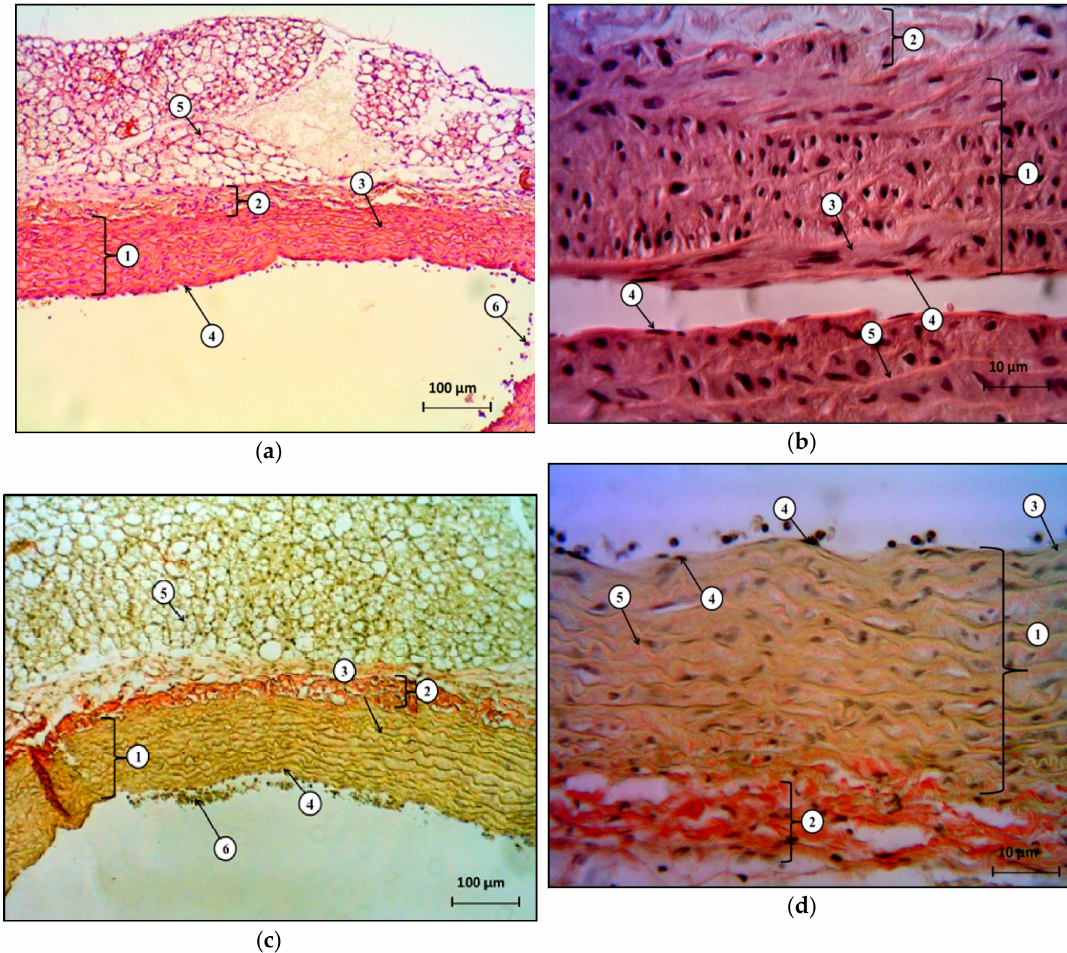
Figure 4. The histological structure of the abdominal aorta in the group with no treatment 43 days after bilateral ovariectomy: ( a ) stained with hematoxylin and eosin, x40; ( b ) stained with hematoxylin and eosin, x400; ( c ) stained by Van Gieson’s method, x40; ( d ) stained by Van Gieson’s method, x400. Designations: ( a ), ( c ): 1—middle shell; 2—outer shell; 3—graduated elastic membranes; 4—endotheliocytes located on the basement membrane; 5—paravasal tissue; 6—blood cells. ( b ), ( d ): 1—the middle shell; 2—the outer shell; 3—the inner shell; 4—endotheliocytes located on the basement membrane; 5—fenestrated elastic